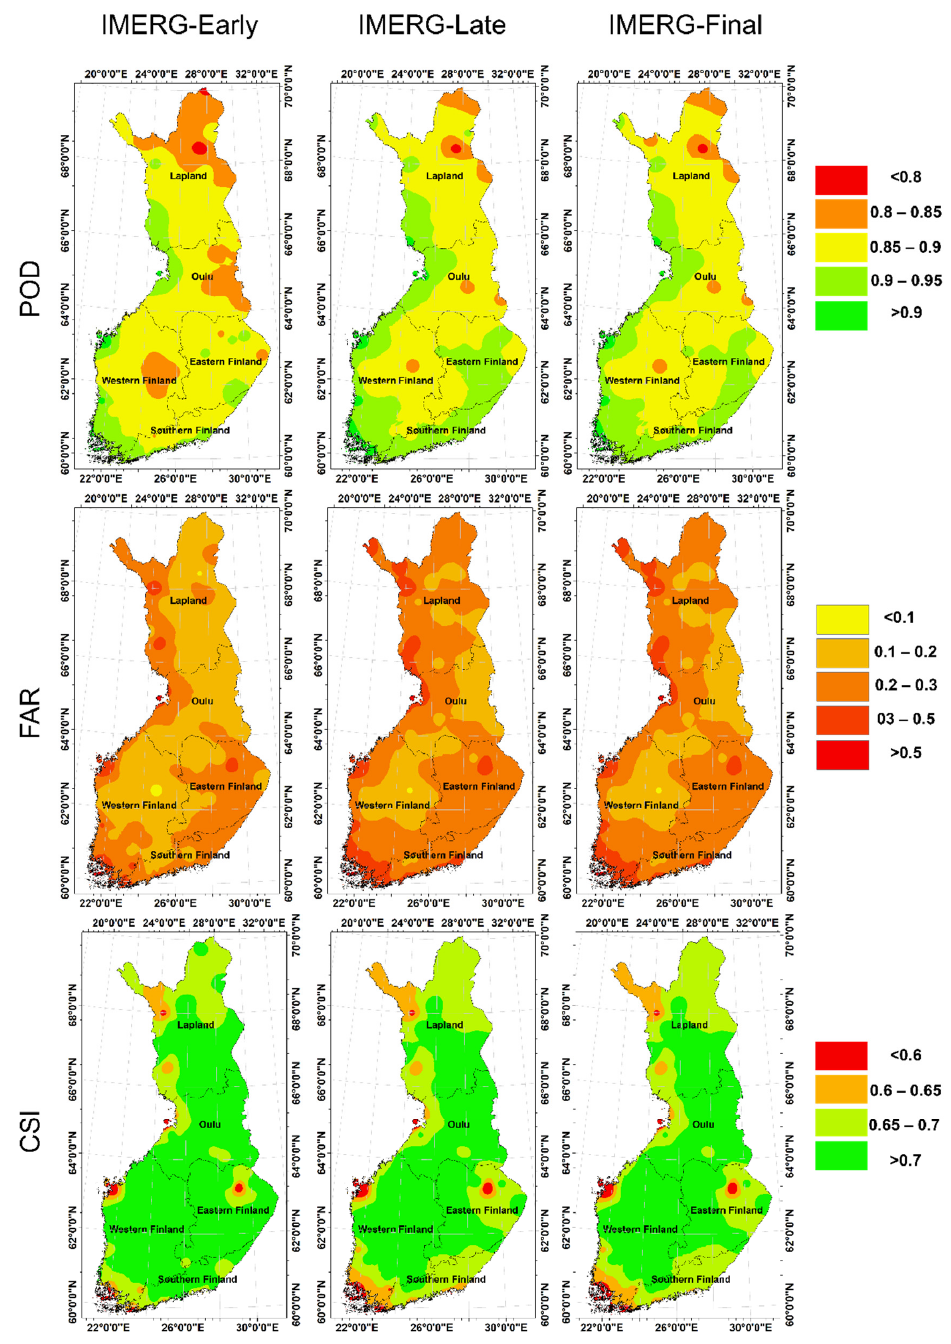
Figure 7. Satellite detection accuracy according to POD, FAR, and CSI.